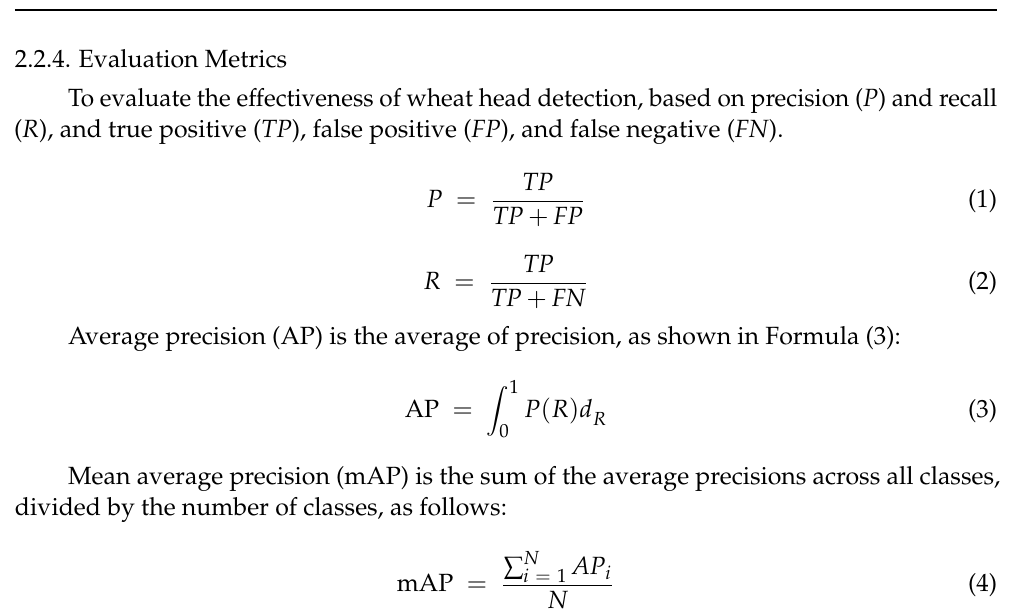
Table 2. Hyper-parameter settings for training. Epochs Batch Size Learning Rate Betas Weight Decay 100